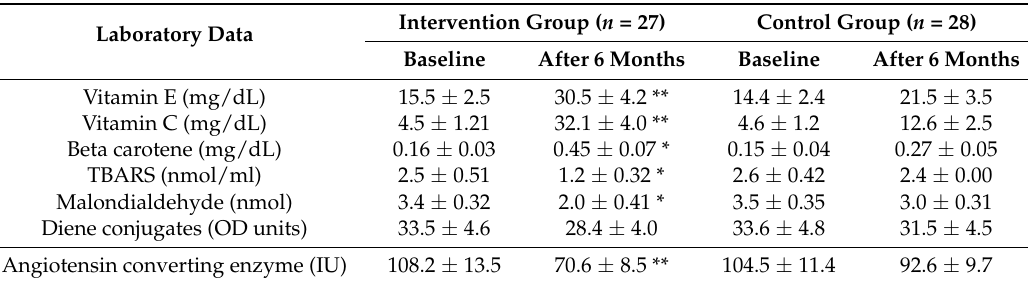
Table 5. Changes in biochemical data after 6